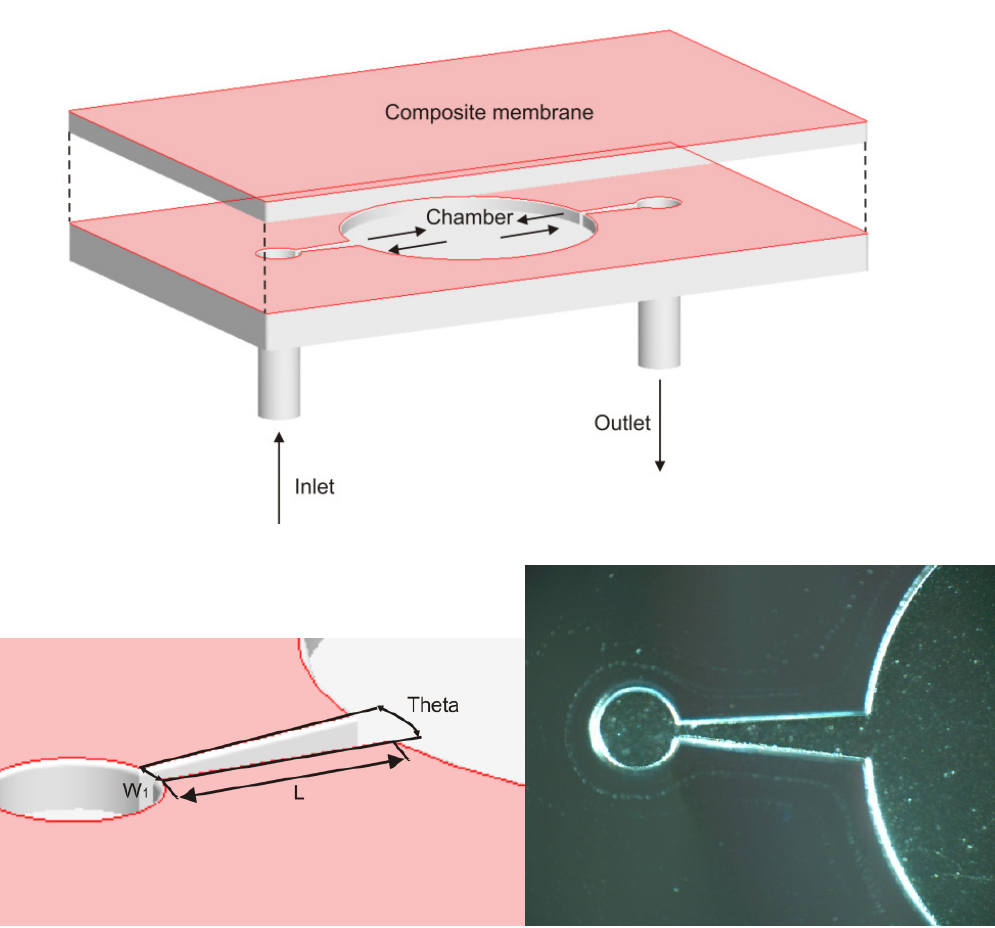
Figure 1. Schematic overview of the valveless